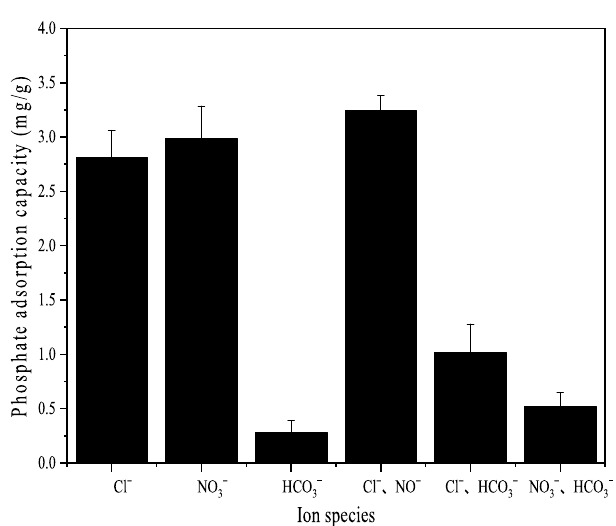
Figure 6. Effect of anion on XT-300 adsorption.